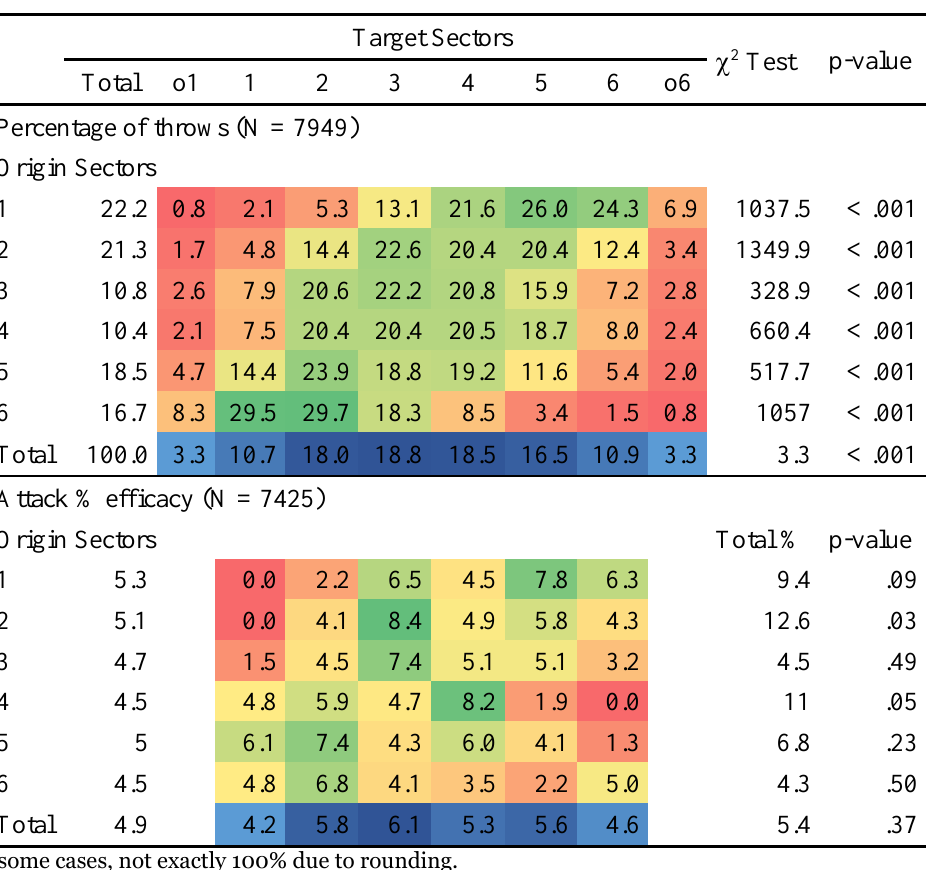
Table 2. Frequency of throws (%) and attack efficacy (%) according to origin sectors, target sectors, and trajectories